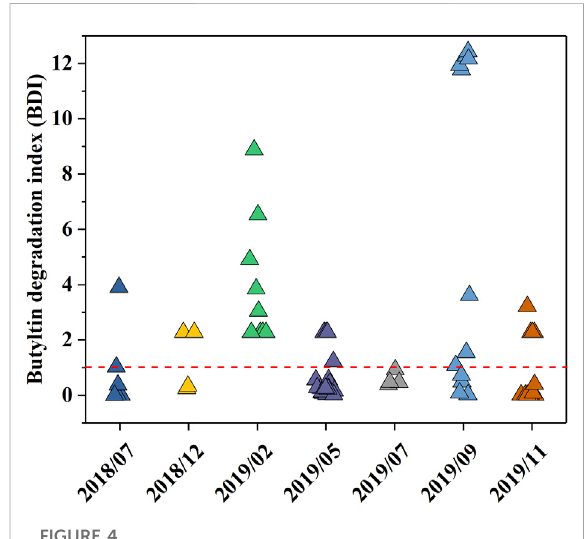
FIGURE 4 Variation in the butyltin degradation index (BDI) among different sampling months in the drinking water source in the upper Yangtze River